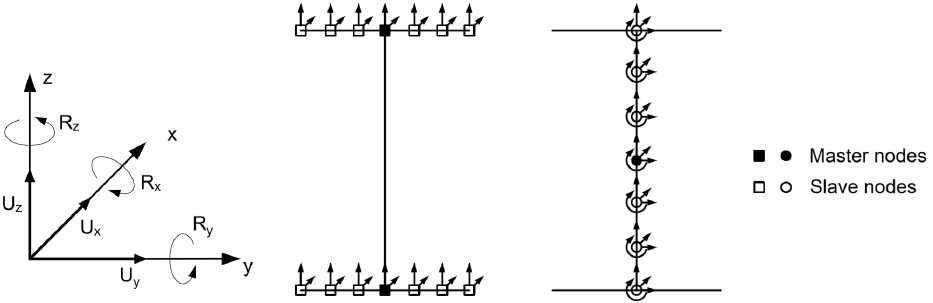
Figure 20. Modelling technique of boundary conditions.